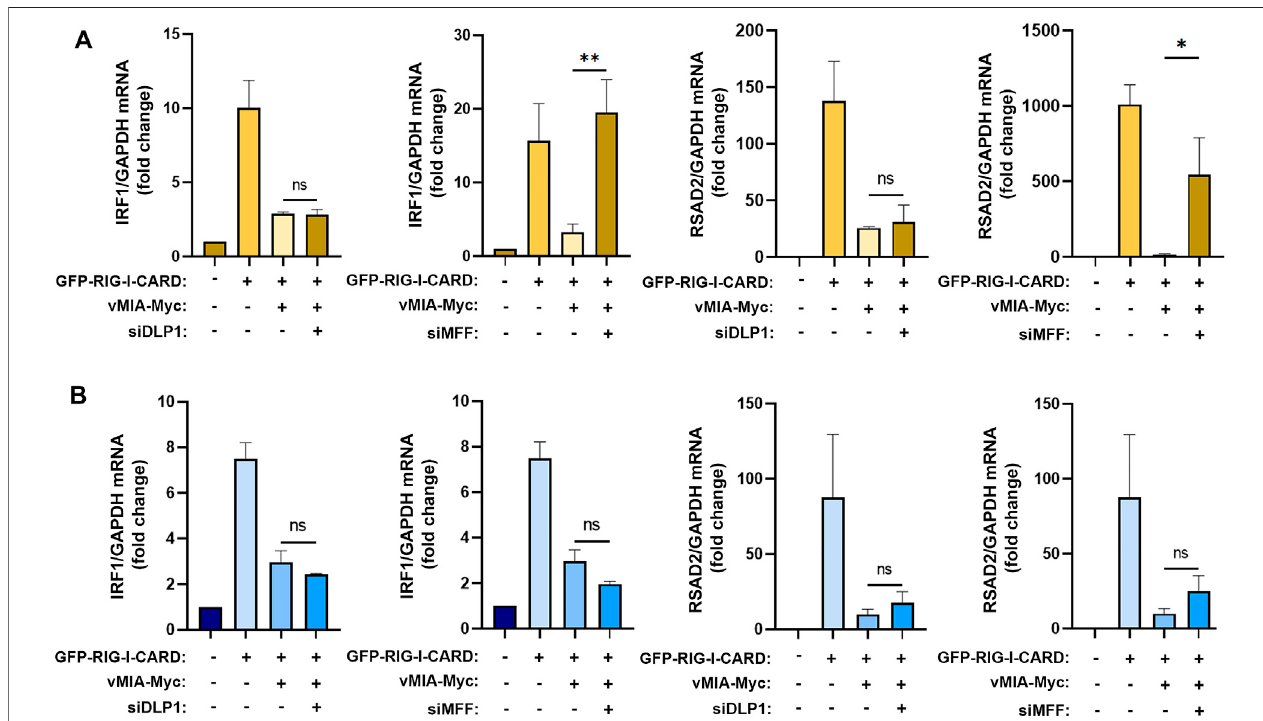
FIGURE 4 | MFF is required for vMIA-mediated inhibition of the MAVS signalling at peroxisomes but not at mitochondria. (A,B) RT-qPCR analysis of IRF1 and RSAD2(viperin)mRNAexpressionin (A) MEFsMAVS-PEXcellsor (B) MEFsMAVS-MITOcellsstimulatedwithGFP-RIG-I-CARD, uponvMIA-Mycoverexpression inthe absenceofDLP1orMFF.GAPDHwasusedasnormalizergeneandgraphsdepictfoldchangeincomparationtountreatedsamples.Datarepresentsthemeans±SEM ofatleastthreeindependentexperimentsanalysedusingone-wayANOVAwithBonferroni ’ smulticomparationstest(ns-non-signi fi cant;* – p < 0.005;** – p < 0.01).